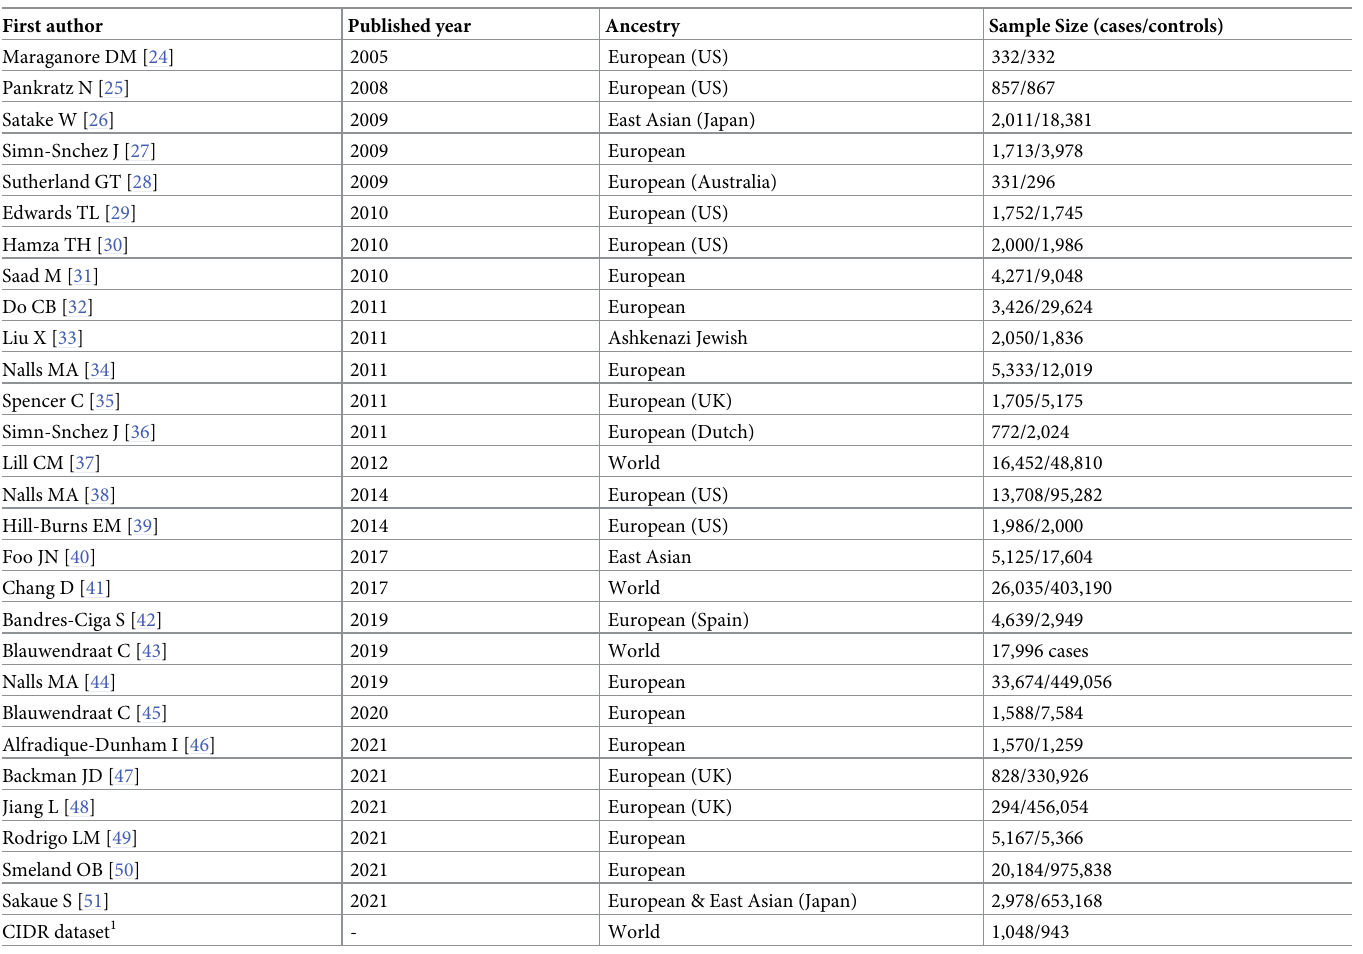
Table 2. The information of studies on PD included in the